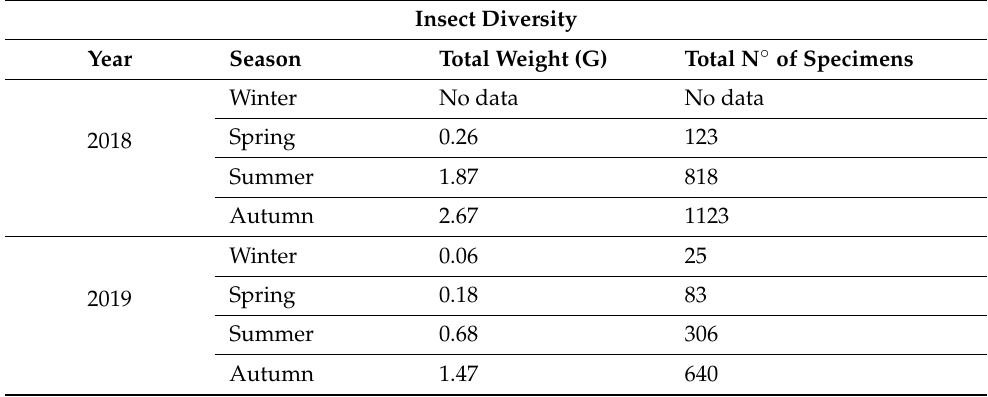
Table 8. Quantification of insect diversity of total biomass and number of specimens captured in all